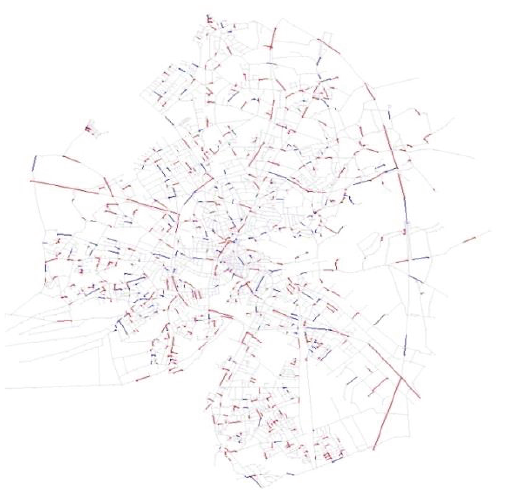
Figure 5: The congested route of Oldenburg city.